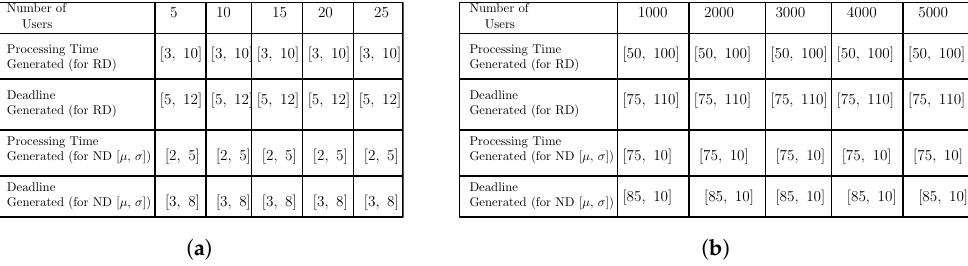
Figure 8. Data set used for comparing FMTM-FSA and MTM-FSA: ( a ) a small DS used for comparing FMTM-FSA and MTM-FSA and ( b ) a large DS used for comparing FMTM-FSA and